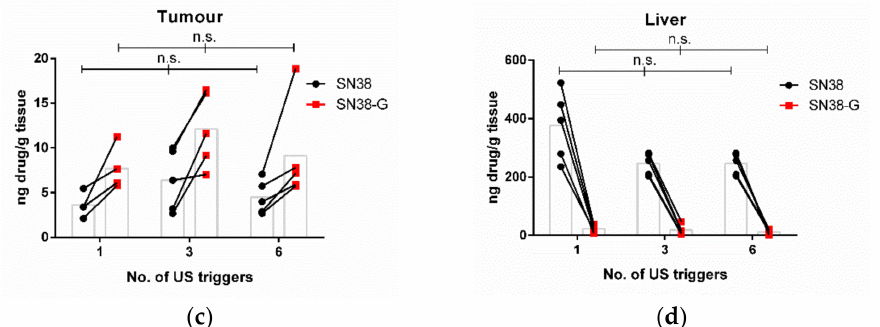
Figure 3. Increasing the number of ultrasound triggers. The effect of timing of the US trigger after bolus injection on drug delivery to tumour ( a ) and liver ( b ) one hour later. Linked data points show the results from individual mice, with the bar in grey showing the mean. Mann–Whitney U test showed no significant differences ( n .s.) between 4 min ( n = 4) and one min ( n = 3) wait time before a single 5 s US trigger for either SN38 or SN38-G in tumour ( a ) or liver ( b ). The effect of increasing the number of 5 s US triggers on tumour drug delivery ( c ) and liver ( d ). Linked data points show the results from individual mice, with the bar in grey showing the mean. ANOVA followed by Dunn’s multiple comparisons test showed no significant differences between 1 ( n = 4), 3 ( n = 5) and 6 ( n = 5) US triggers for either SN38 or SN38-G in tumour ( c ) or liver ( d ).